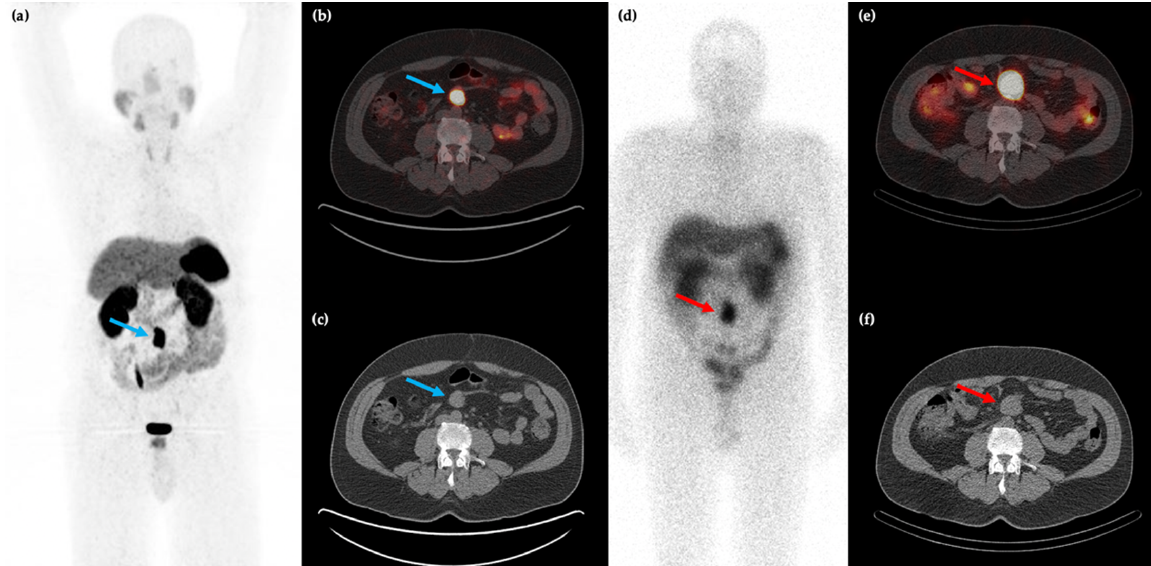
Figure 1. 58-year-old male with a history of rectal bleeding and a mesenteric mass identified on conventional CT imaging. 68 Ga-DOTATATE PET/CT maximum intensity projection (MIP) ( a ) and axial ( b , c ) images shows the somatostatin receptor (SSTR) positive lesion at the root of the small bowel mesentery (blue arrows) with improved spatial resolution compared to 111 In-pentreotide SPECT/CT ( d – f , red arrows).